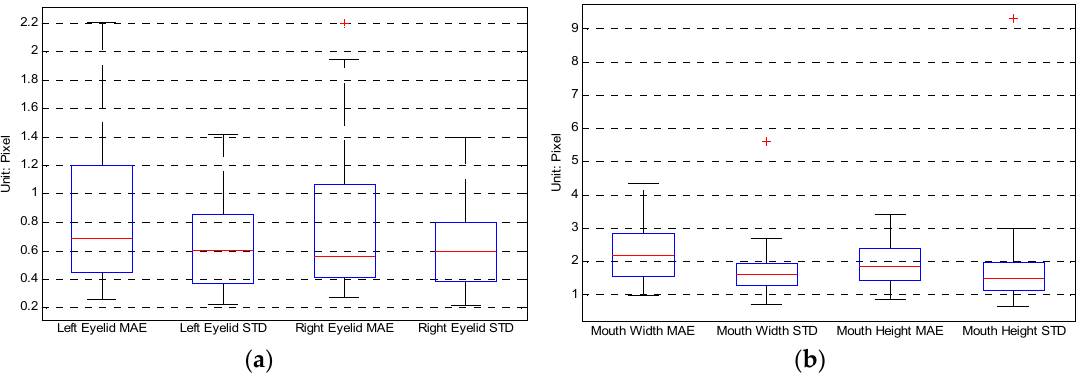
Figure 4. Boxplot of the mean absolute error (MAE) and standard deviation (STD) of the 31 videos. ( a ) Boxplot of eyelid distance MAE and STD; ( b ) boxplot of mouth width and height MAE and STD. error = [2.6, 1.6]